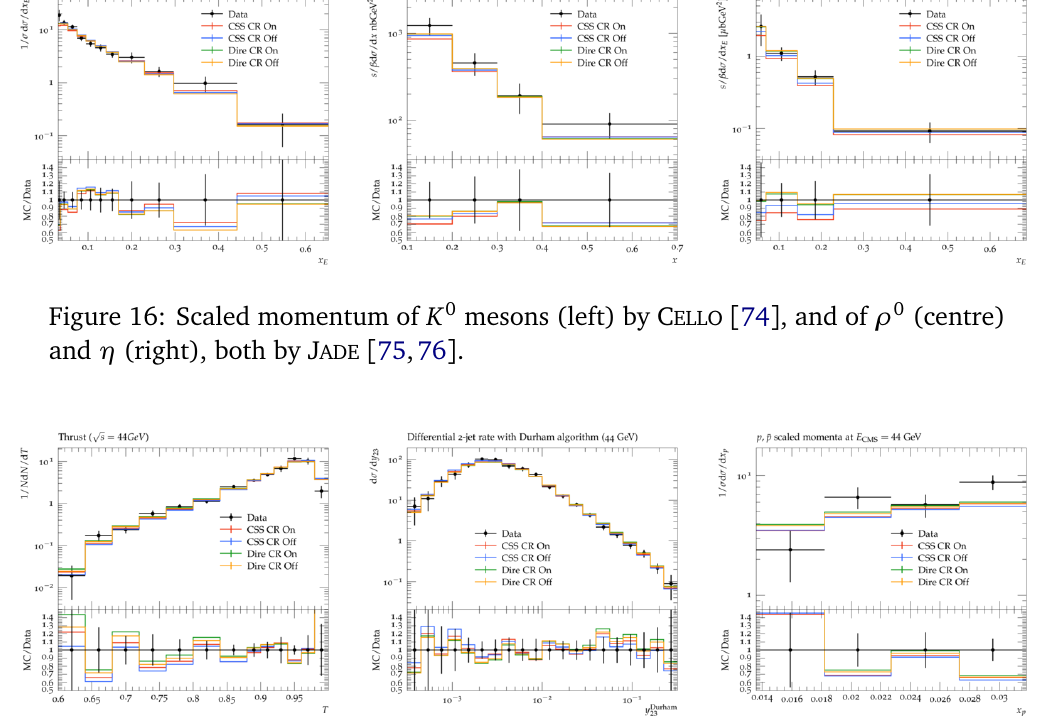
Figure 17: S HERPA results for thrust (left), the differential 2-jet rate in the Durham scheme (middle) and p , ¯ p scaled momenta (right) compared to results from T ASSO [ 70 ] , J ADE -O PAL [ 51 ] , and T ASSO [ 77 ] , respectively.